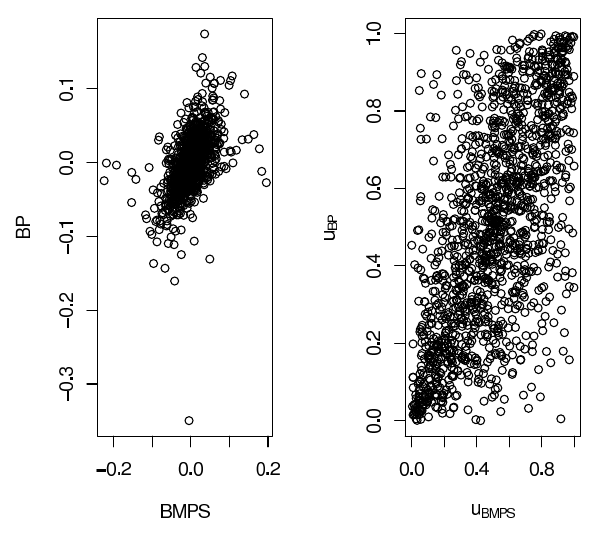
Figure 5 { Scatterplot of the log-returns of the investments of Monte dei Paschi di Siena (BMPS) and Banco Popolare (BP) on the left and of the transformed data on the right.